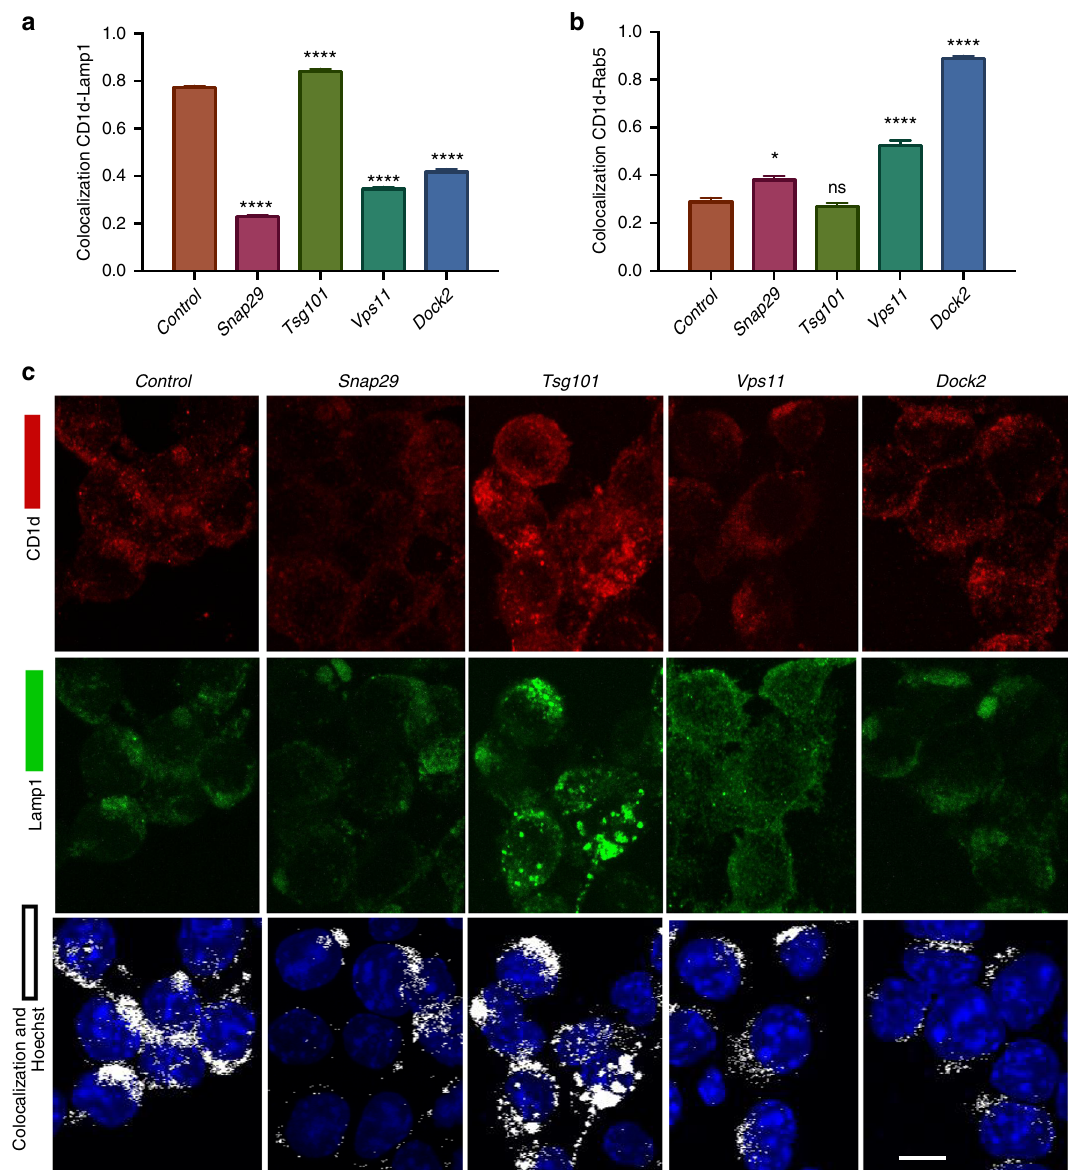
Fig. 6 Effects on CD1d traf fi cking to the lysosome. a Co-localization coef fi cient of CD1d with the late endosomal marker, Lamp1 or early endosomal marker Rab5 after knockdown of the indicated genes in J774-CD1d cells. Representative data from one of two experiments in which at least 200 cells per condition were analyzed. b Representative images for the CD1d and LAMP1 co-localization after knockdown of the indicated genes in J774-CD1d cells. Scale bar 10 μ m. Graphs represent mean ± SEM. * p < 0.05; **** p < 0.0001 (one-way ANOVA). See also Supplementary Fig. 7, 8, and